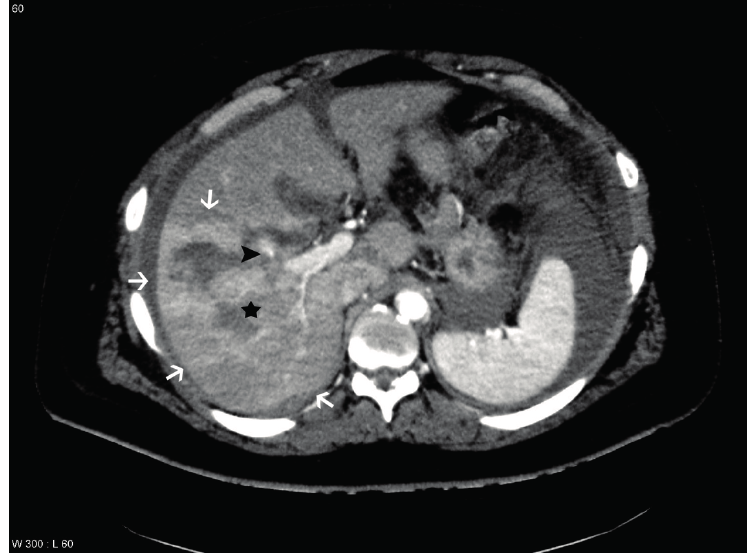
Figure 3. Patient with liver lesion in segment 5, 6, 7 and 8. THAD is seen in the periphery of the lesion and pseudoaneurysm and arteriovenous fistula (PS/AF) is not present according to the gold standard. However, one observer suspected a pseudoaneurysm, which is marked with a black arrowhead. The liver lesion is marked with a black star and the areas with THAD are marked with white arrows.